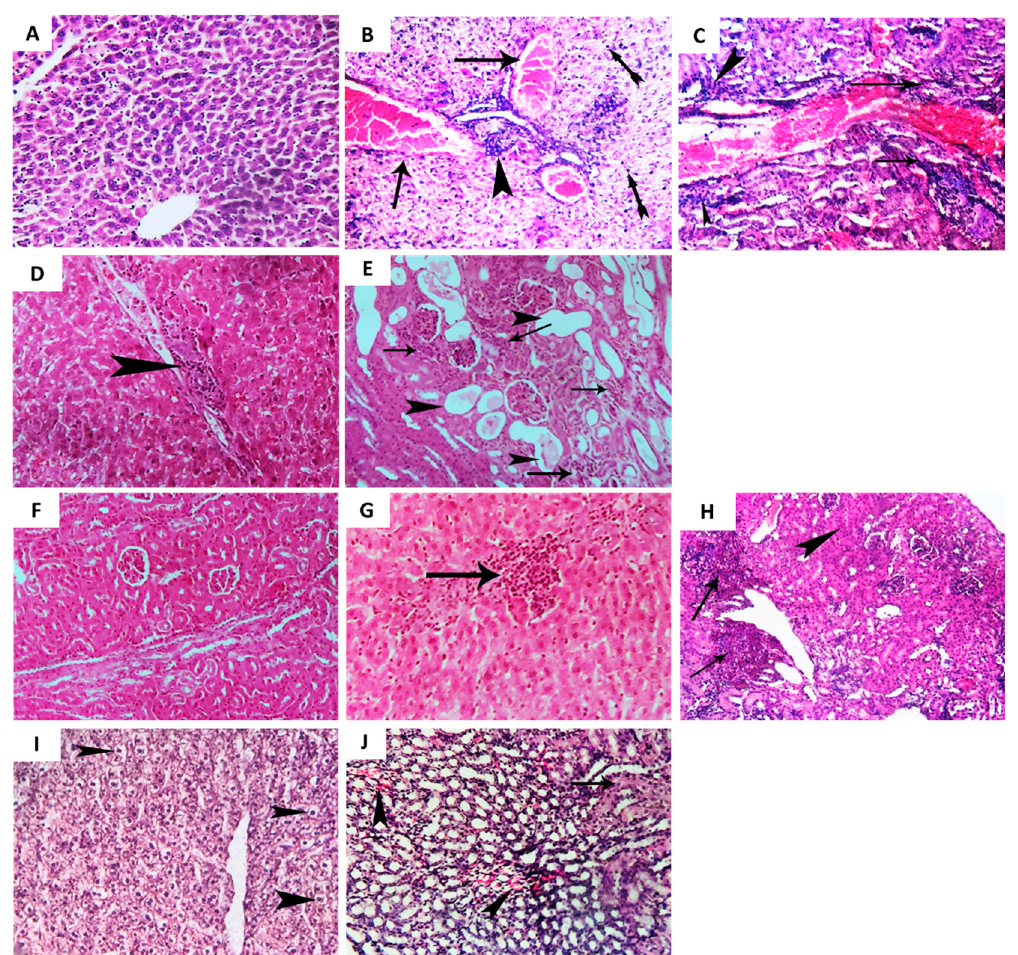
Figure 6. Histopathological examination of liver and renal tissues. Five groups of three-week-old albino mice ( Mus musculus ), with each group including five mice, were used in the experiment. Two negative control groups were intraperitoneally injected with sterile PBS or not infected. Two positive control groups were intraperitoneally injected with P. aeruginosa PAO1 (1 × 10 6 CFU/mL) or with dimethyl sulfoxide-treated P. aeruginosa PAO1. The test group was injected with allopurinol-treated P. aeruginosa PAO1 (1 × 10 6 CFU/mL). The mice were observed for five days and then euthanized by cervical dislocation. Both kidneys and liver were dissected from mice, rinsed with normal saline, and fixed in neutral buffered formalin (10%) for histopathological examination. Representative photomicrographs (H&E × 200) are depicted from control (un-infected), P. aeruginosa infected, and P. aeruginosa treated with allopurinol (1/10 MIC) mice groups. ( A ) Photomicrograph of mice liver from the non-infected (control) group showing apparently normal tissue architecture and cellular details. ( B , C ) Photomicrographs of mice liver from the P. aeruginosa infected group showing diffuse severe congestion of hepatic blood vessels (arrows) with perivascular cellular infiltration and colonization of P. aeruginosa rods (arrowheads), coagulative necrosis represented by pyknosis (tailed arrows), and the focal area of leucocytic cell infiltrated hepatic parenchyma with colonization of P. aeruginosa rods (arrows). ( D , E ) Photomicrographs of mice liver from the allopurinol-treated P. aeruginosa group showing mild perivascular leucocytic cells infiltration (arrowheads) with a few scattered P. aeruginosa rods in addition to mild congestion. ( F ) Photomicrograph of mice kidney from the non-infected (control) group showing apparently normal renal cortex with normal glomeruli and renal tubules. ( G , H ) Photomicrographs of mice kidney from the P. aeruginosa infected group showing perivascular colonization of P. aeruginosa (arrows) with cellular infiltration (arrowhead, ( G )), leucocytic cell infiltration, hyperplasia of renal epithelium (arrowhead, ( H )), and degenerated renal tubules. ( I , J ) Photomicrographs of mice kidney from the allopurinol-treated P. aeruginosa group showing mild focal infiltration of a few P. aeruginosa rods and less leucocytic cell infiltration (arrows ( I )) beside milder cystic dilation of some renal tubules (arrowheads), and focal mild degeneration of some renal tubules (arrows ( J